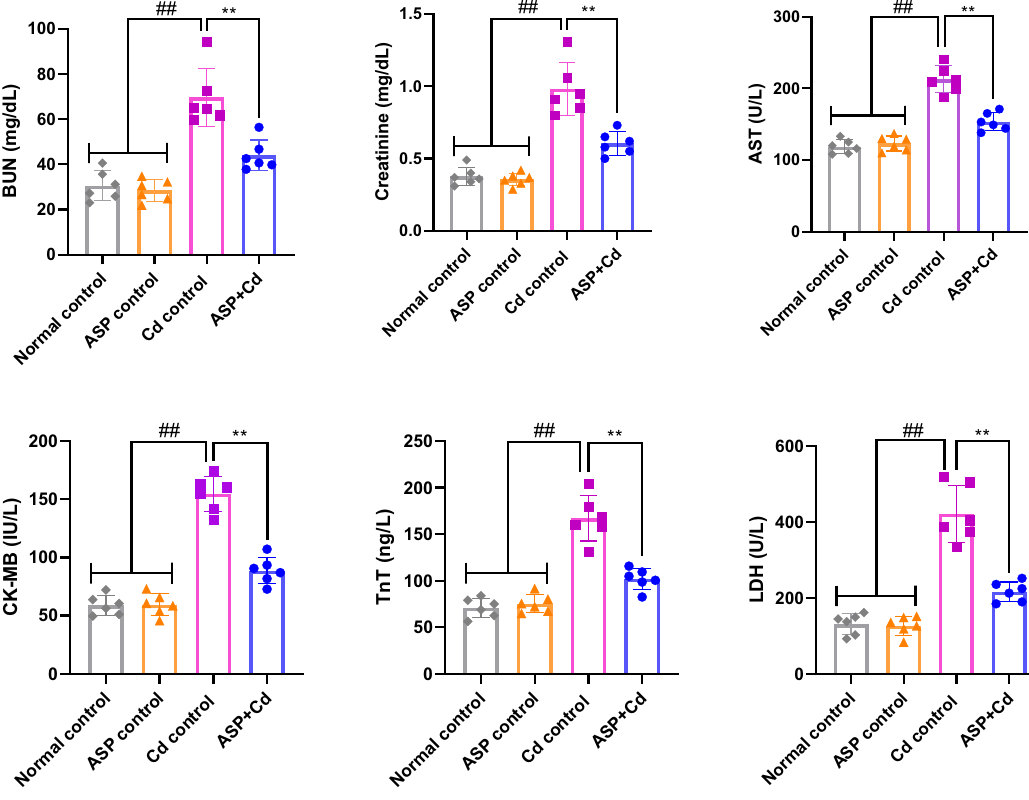
Figure 1. Effects of asperuloside on serum BUN, creatinine, AST, CK-MB, TnT and LDH of cadmium administered rats. Histograms represent the mean ± SD (n = 6). For all panels: ## p < 0.05 compared to normal and ASP control groups; ** p < 0.05 compared to Cd control